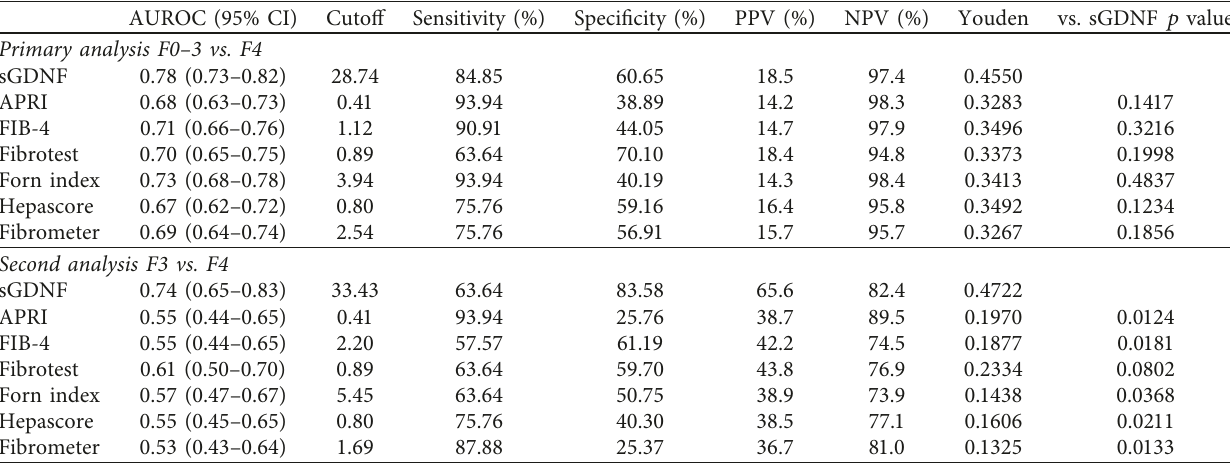
AUROC of sGDNF vs. APRI, FIB-4, fibrotest, forn index, hepascore, fibrometer via DeLong test. NPV, negative predictive value; PPV, positive predictive value; Se, sensitivity; Sp, specificity. APRI, aspartate transaminase-platelet ratio index; FIB-4, fibrosis-4 index; APRI: (AST (U/L)/upper normal limit) × 100/ platelets(10 9 /L).FIB-4 index:age(years) × AST (U/L)/(PLT(10 9 /L)) × (ALT (U/L) 1/2 ).Fibrometer: − 0.007PLT (G/L) − 0.049PI(%)+0.012AST